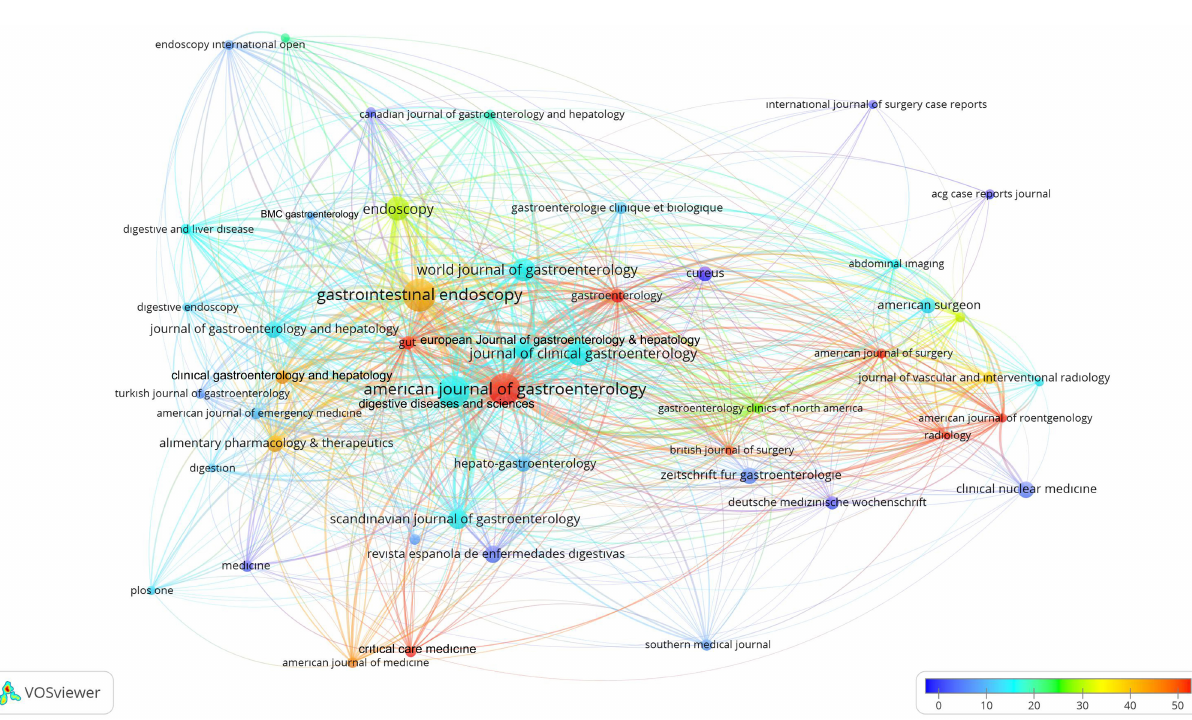
Figure 5. Network visualization map for citation analysis of active journals on gastrointestinal bleeding. The size of the circle shows a large number of articles. The number of citations from blue to red (blue -gree n-yel low-r ed)